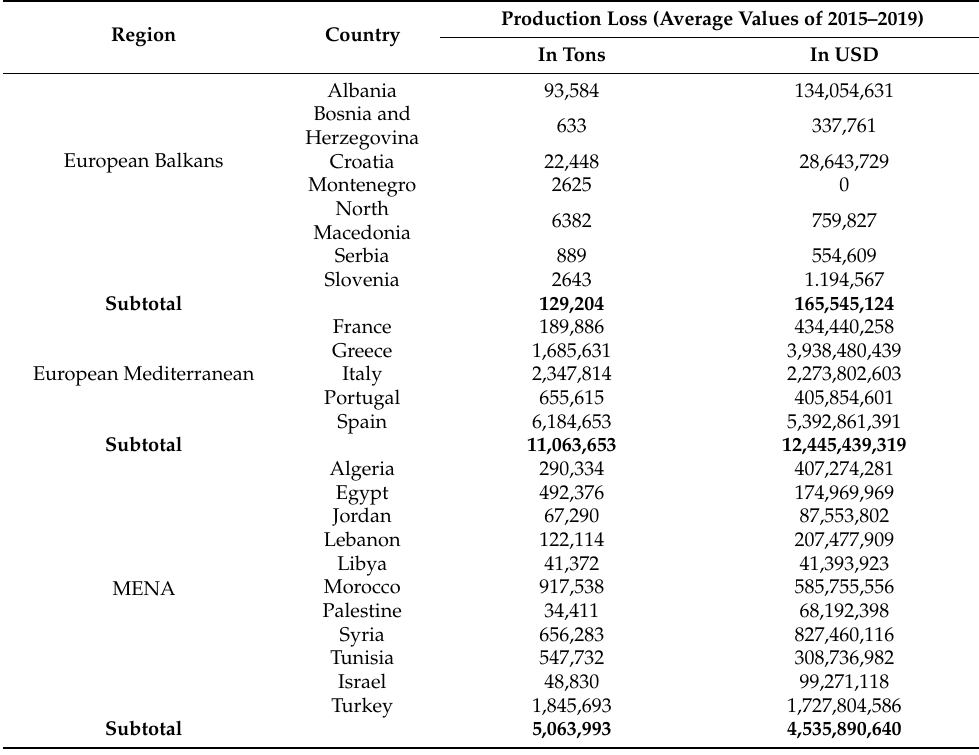
Table 2. Economic impacts of Xylella fastidiosa on olives, grapes, Citrus spp. and almonds in the Mediterranean basin.